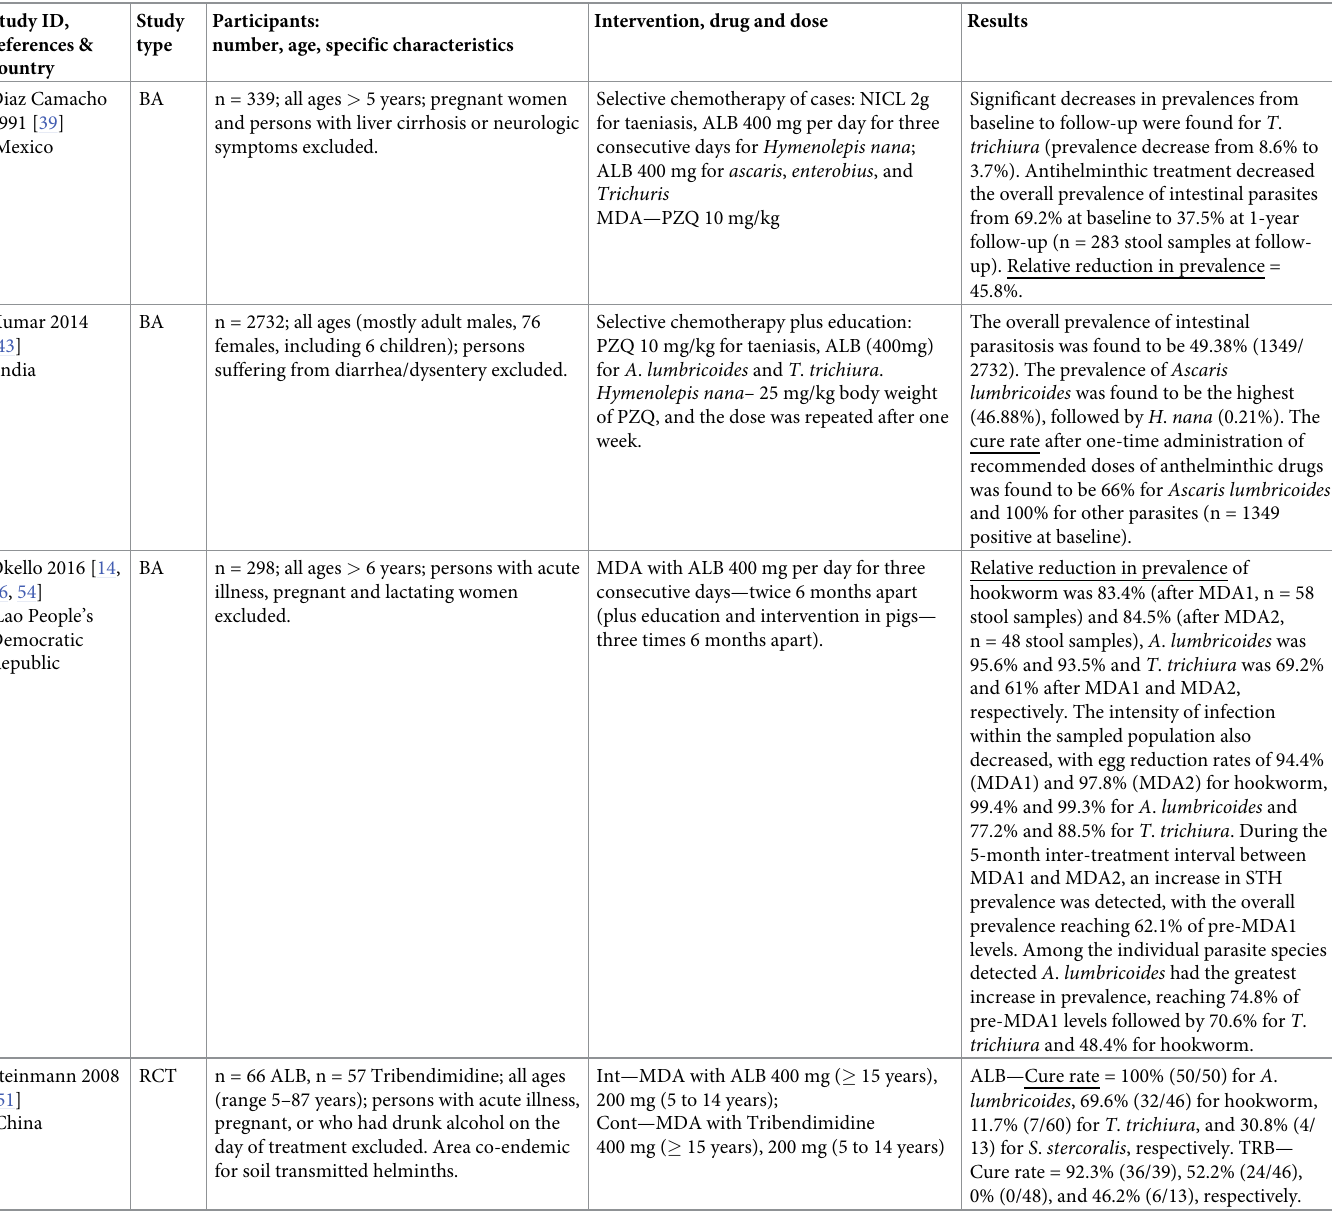
Table 3. Results for soil-transmitted helminths (n =